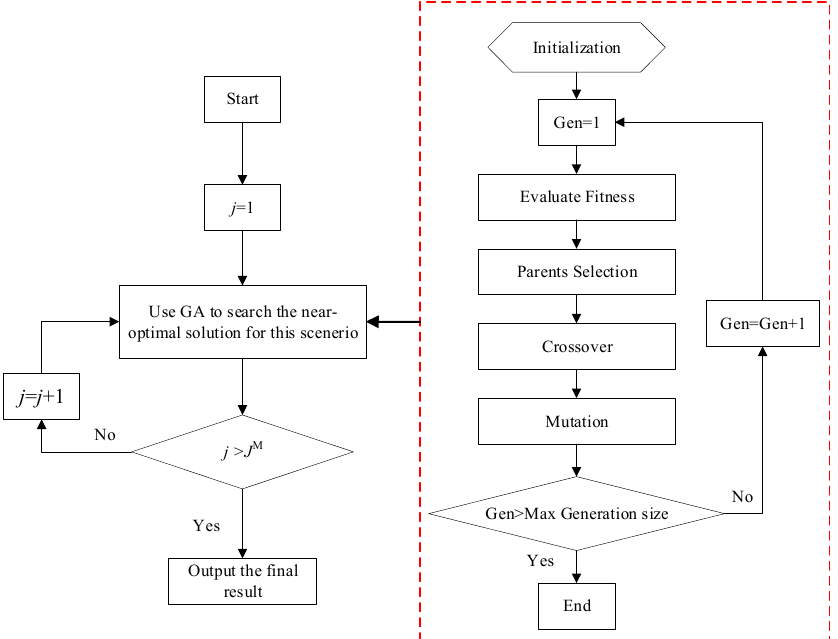
Figure 3. The solution procedure.